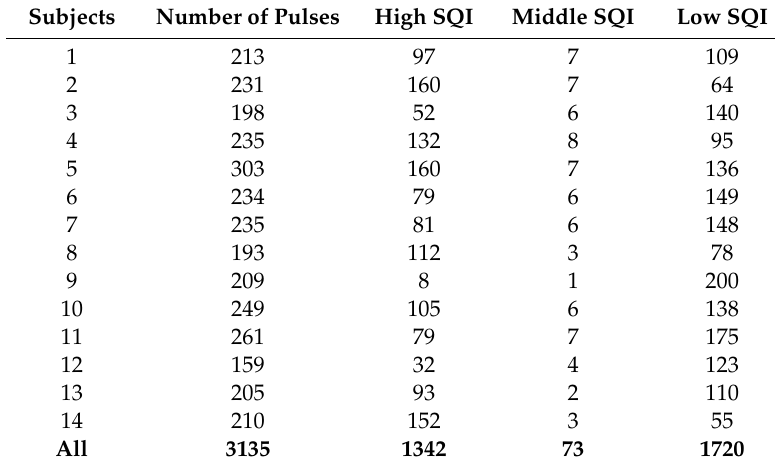
Table 3. Quality information of PPG pulses for fourteen